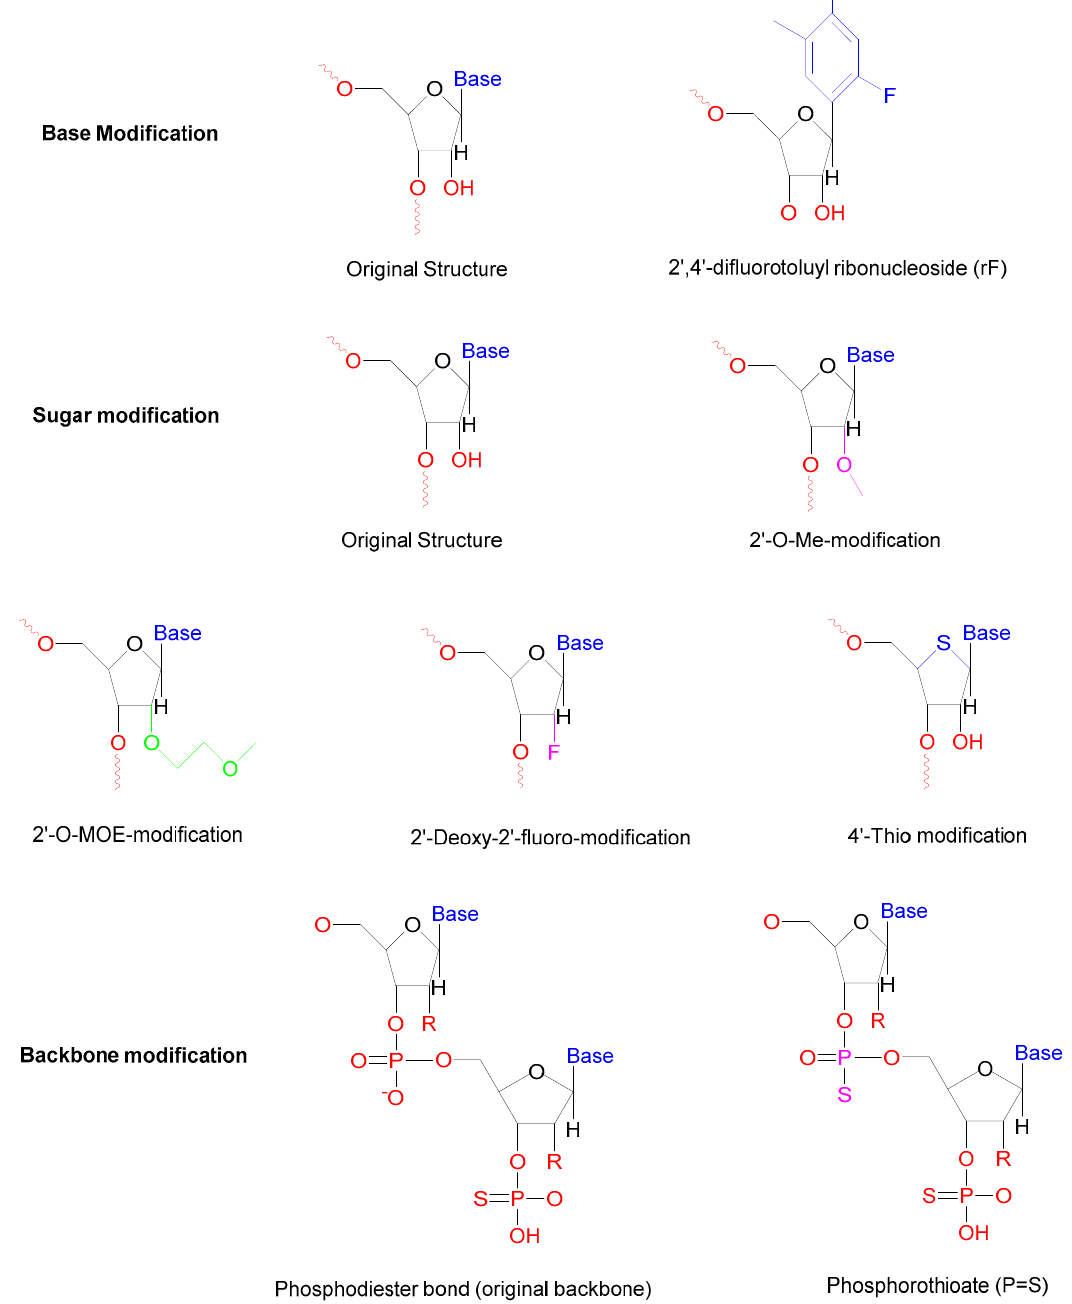
Figure 3. Chemical modifications of